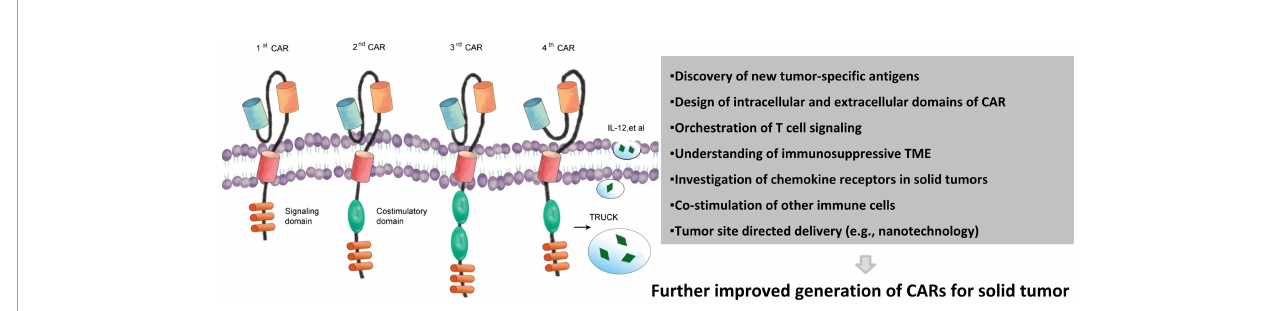
FIGURE 3 | Chimeric antigen receptors and main challenges of treating solid tumors. Evolution of CAR from the fi rst generation to the fourth generation. First-generation CARs. Second-generation CARs embody an additional intracellular signaling domain to the fi rst-generation receptor con fi guration and provide a co-stimulatory signal. Third- generation receptors incorporate two co-stimulatory domains with the T-cell-activating signaling domain. Fourth-generation CARs or TRUCKS (T cells redirected for universal cytokine killing) carry vectors that encode a CAR and a CAR-responsive promoter as well as respond to the successful signaling of CAR by the transgenic production of cytokines such as IL-12. Upon accumulated knowledge of solid tumors and their surrounding environment, more effective CAR therapeutic products may be generated. CAR, chimeric